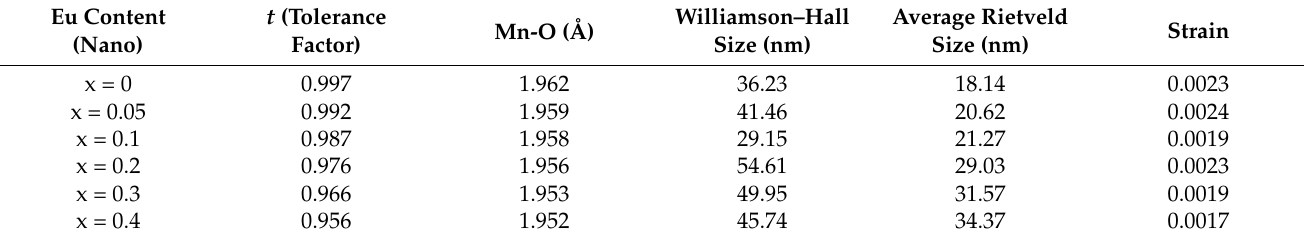
Table 1. Calculated tolerance factors, Mn-O lengths, and crystallite sizes for nanocrystalline samples using the Williamson–Hall and Rietveld methods, including strain